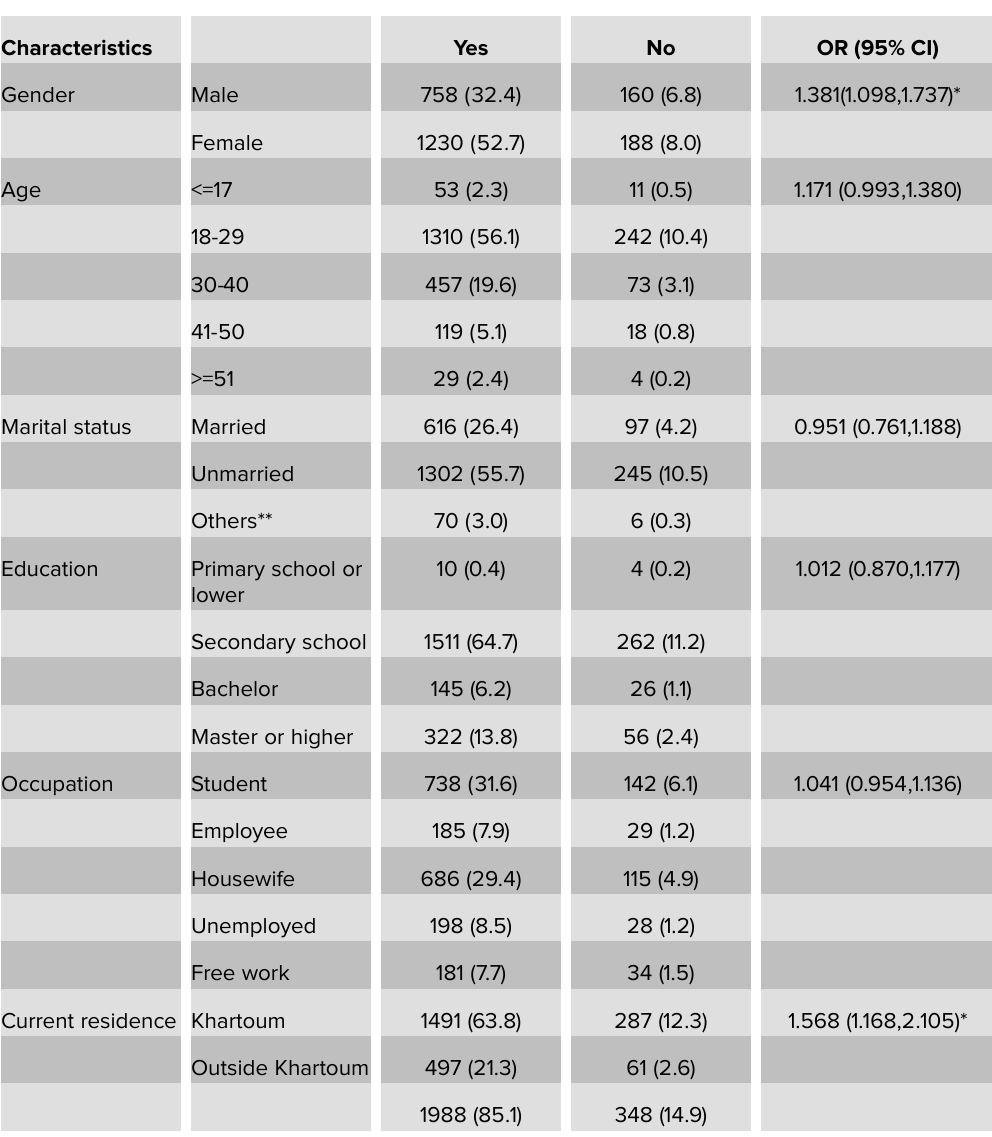
TABLE 3: Attitudes towards COVID-19 by demographic variables, (do you think that COVID-19 will be successfully controlled?)